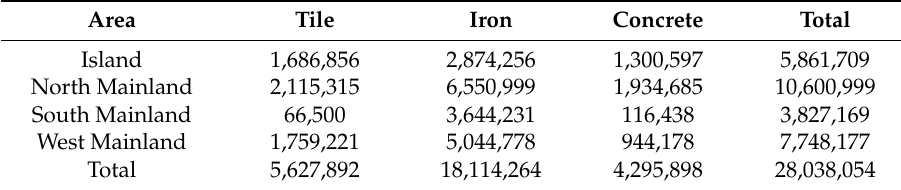
Table 9. Area of different roof materials (in m 2 ) resulting from automatic image classification for the whole investigation area. Tile